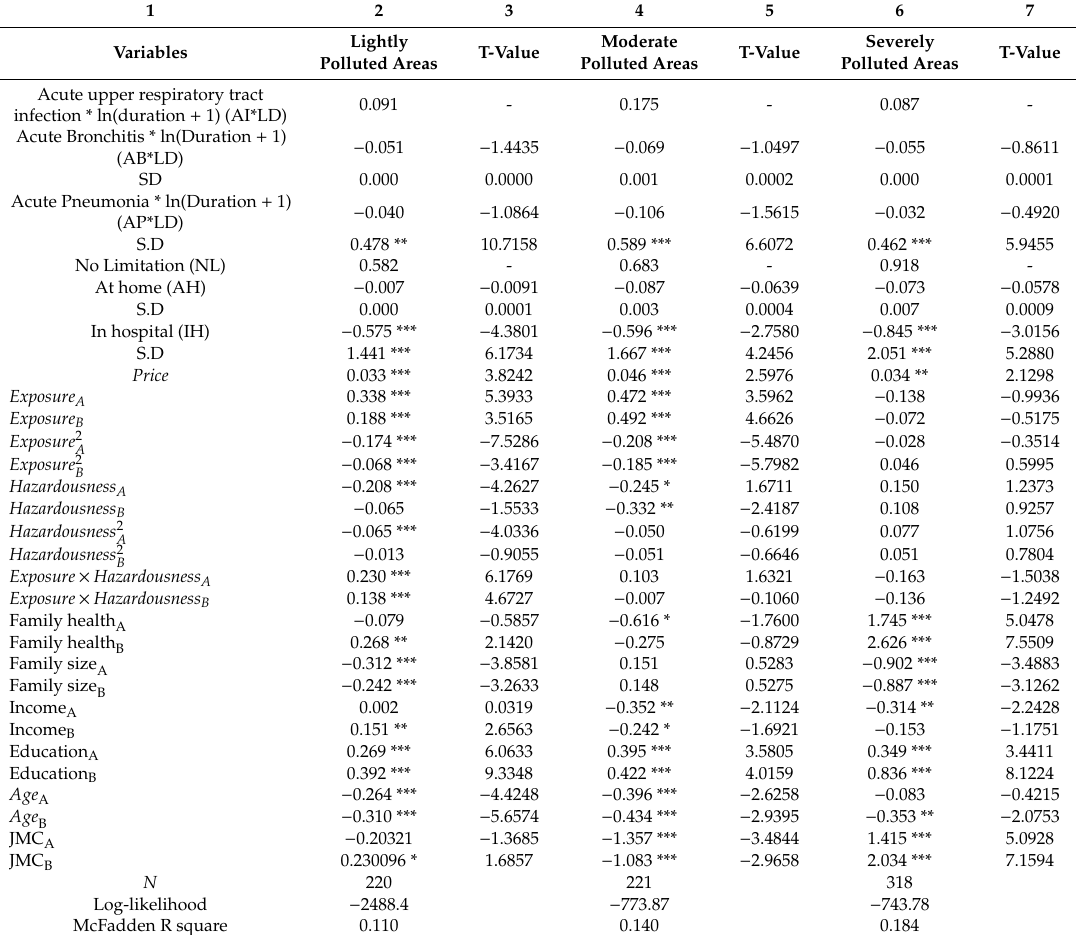
Table 5. Heterogeneous e ff ects of perceived health risk on choice behavior, by proximity to pollution source.